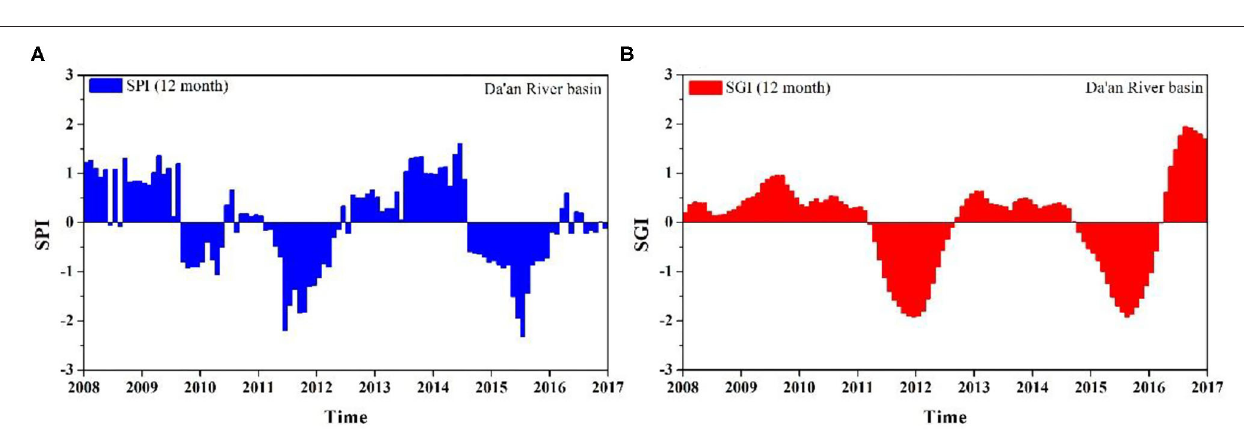
FIGURE 3 | (A,B) Long-term ( q = 12) SPI and SGI analysis results for the Da’an River